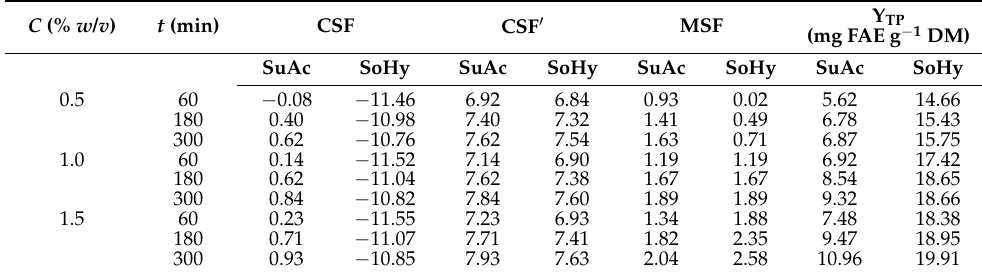
Table 2. Combined severity factor (CSF), alternative combined severity factor (CSF (cid:48) ), and modified severity factor (MSF) values, along with the corresponding total polyphenol yield (Y TP ) values, for the various treatments tested. Assignments SuAc and SoHy correspond to treatments with sulfuric acid and sodium